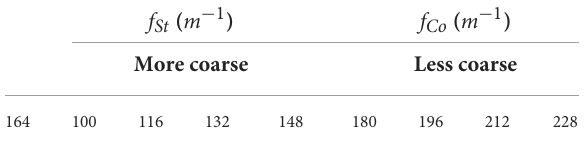
TABLE 2 The set of experimental